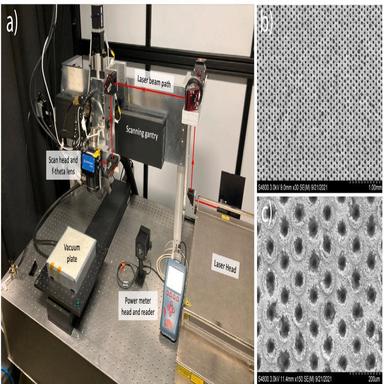
(a) The benchtop ultrafast-laser scriber and associated equipment used to prepare samples analyzed in this work. (b) and (c), SEM images, at 2 different magnifications, of laser-ablated pore arrays on a lithium nickel manganese oxide (NMC) electrode.